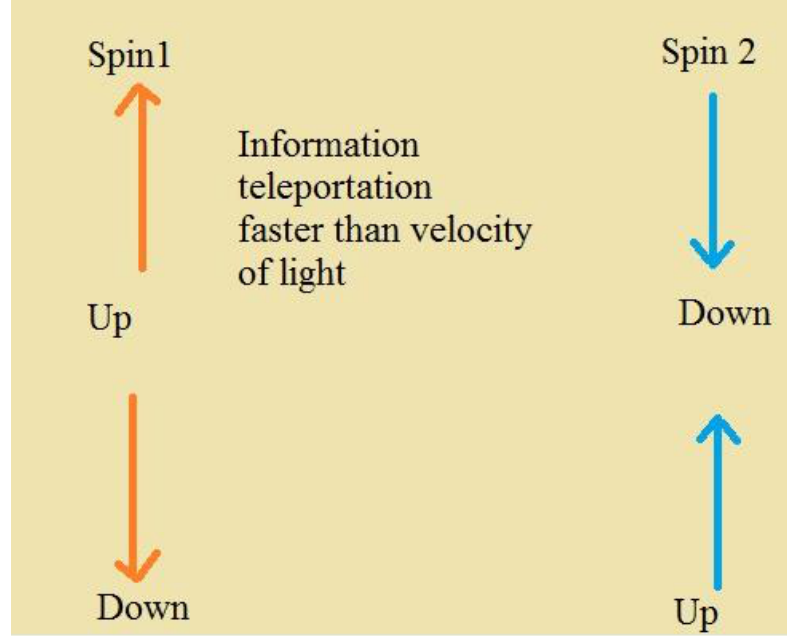
Figure 1. Two spinors exchange information with velocity faster than light—a hypothesis.